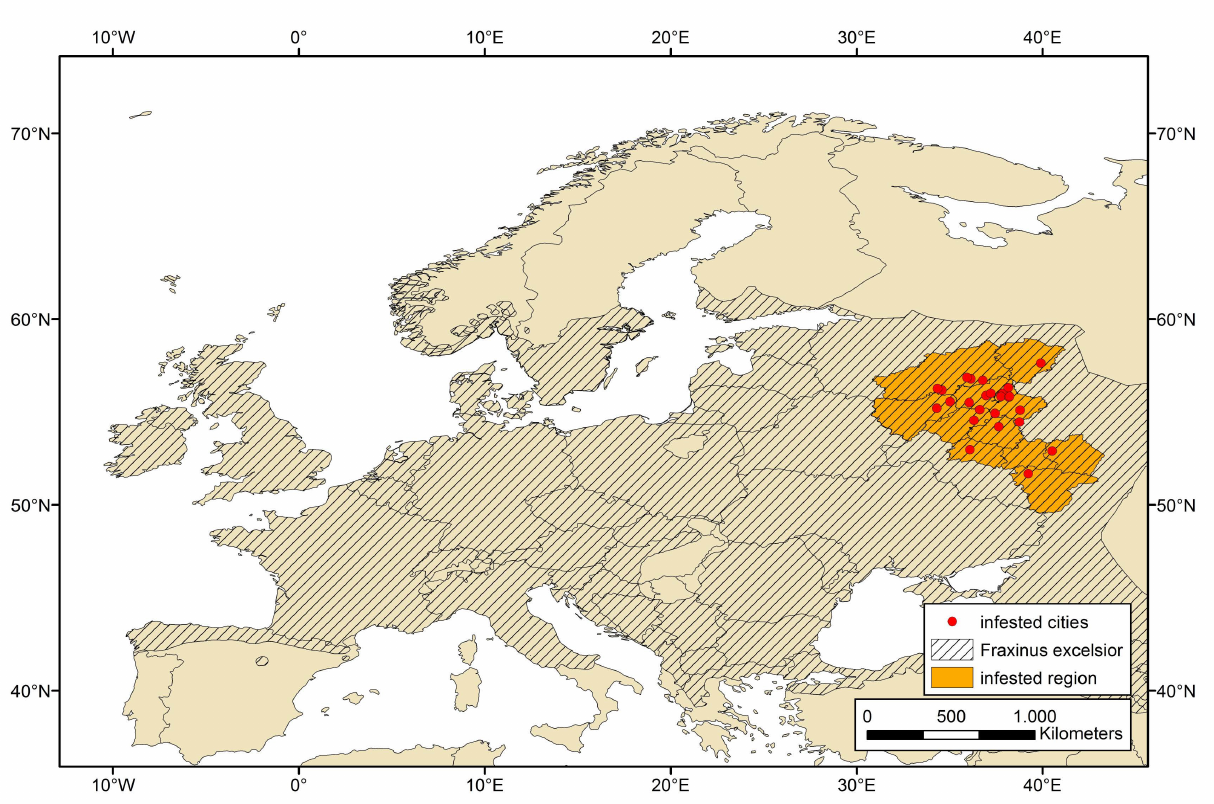
Figure 2. European range of Agrilus planipennis , showing infested regions of Russia (orange) and cities (red) where the beetle has been detected together with the distribution of Fraxinus excelsior [11]. Based on